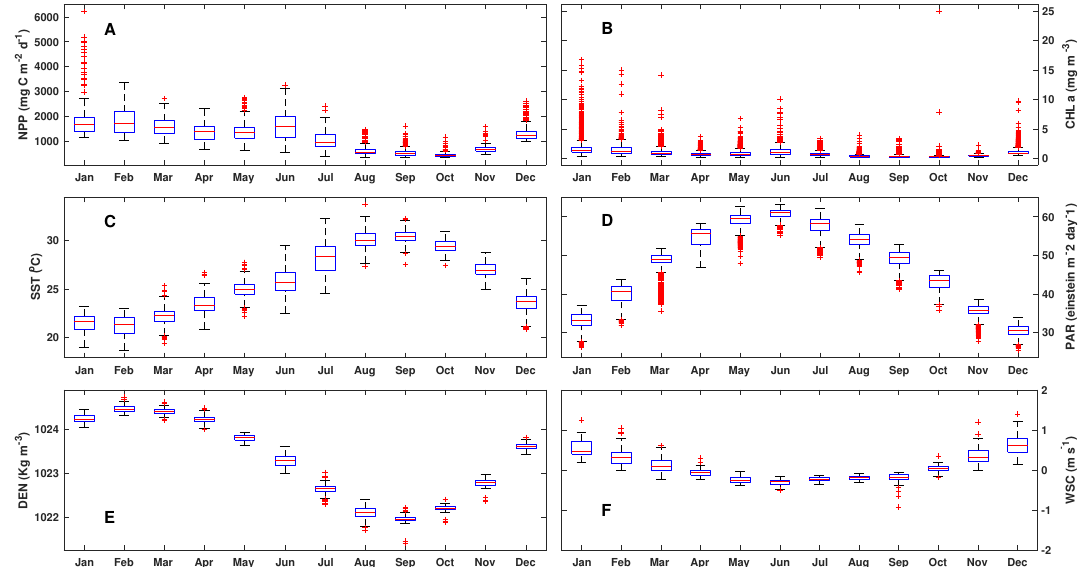
Figure 3. Monthly climatologies cycle box plots [25–75% percentiles (box)], 5–95% percentiles (bars), and median and extreme values of: ( A ) net primary productivity (NPP), ( B ) Chlorophyll-a (Chl-a), ( C ) sea surface temperature (SST), ( D ) photosynthetically available radiation (PAR), ( E ) relative surface density (DEN), and ( F ) wind stress curl